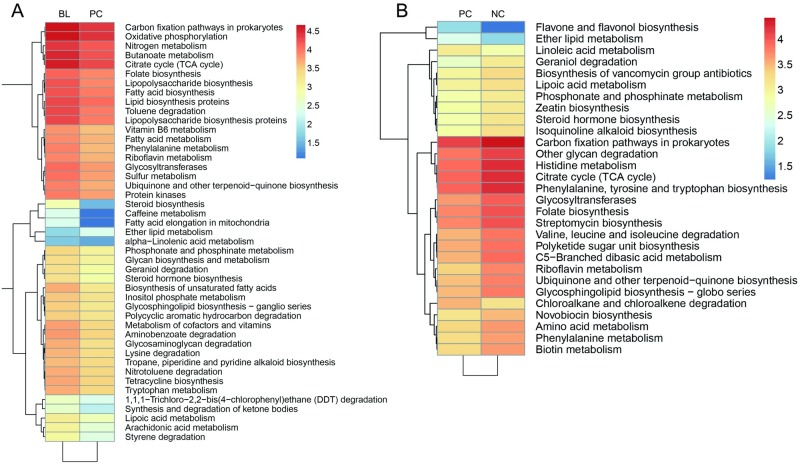
Predicted functional profiles of the cecal microbiota of control chickens and those with C. perfringens, Eimeria challenge and fishmeal supplementation, in the presence and absence of Bacillus licheniformis.Differences between groups were assessed using a bootstrap Mann–Whitney U-test with cutoffs of P < 0.01, false discovery rate < 0.1, and mean counts >10. NC, negative control; PC, treated with C. perfringens, coccidia, and fishmeal; BL, pre-treated with B. licheniformis then treated with C. perfringens, coccidia, and fishmeal.